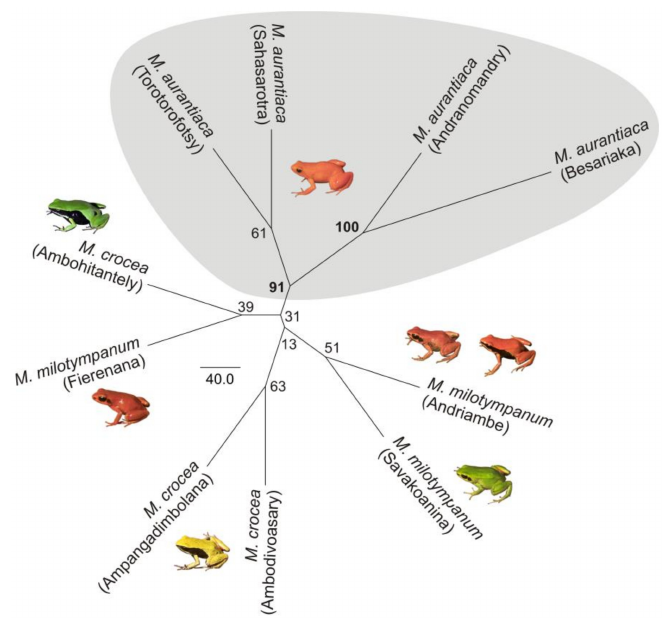
Figure 7. Dendrogram of the sampling localities used for the population structure analyses with nine microsatellite loci. Only the four analyzed populations of M. aurantiaca form a substantially supported cluster (bootstrap support 91%).